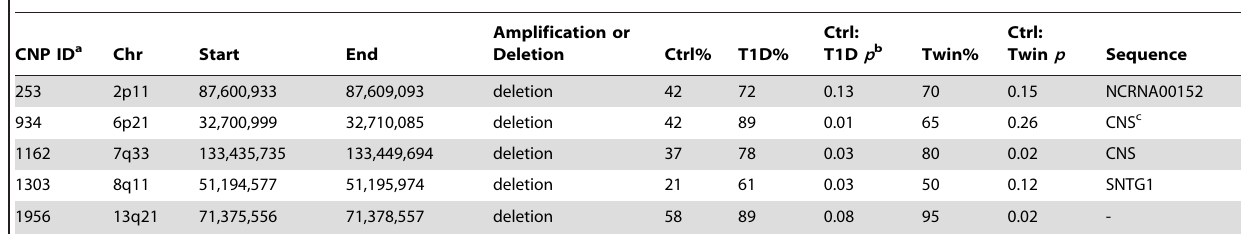
Table 1. CNVs enriched in T1D and Twin cohorts, relative to Ctrl.